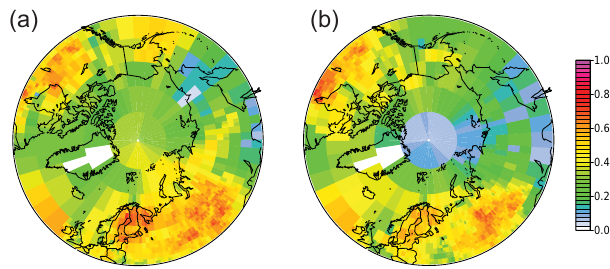
Figure 9. Fractional uncertainty reduction for 2009 for scenarios S1 and S2 (a) , and S3 (b)